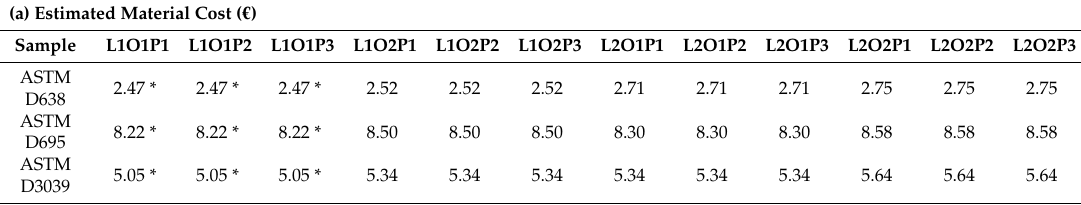
Table 11. Estimated material cost of each parameter combination and the fitted regression